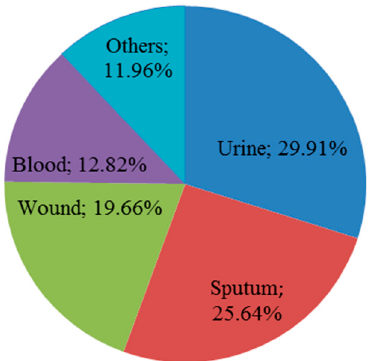
Figure 1. The distribution of collected isolates according to their origin: urine (29.91%), sputum (25.64%), wound (19.66%), blood (12.82%), and others (endotracheal aspirate (4.27%), central venous pressure tip (1.71%), cerebrospinal fluid (0.85%), pleural fluid (0.85%), drain culture (0.85%), bedsore (0.85%), bile culture (0.85%), central venous line culture (0.85%), and aspirate fluid (0.85%)).